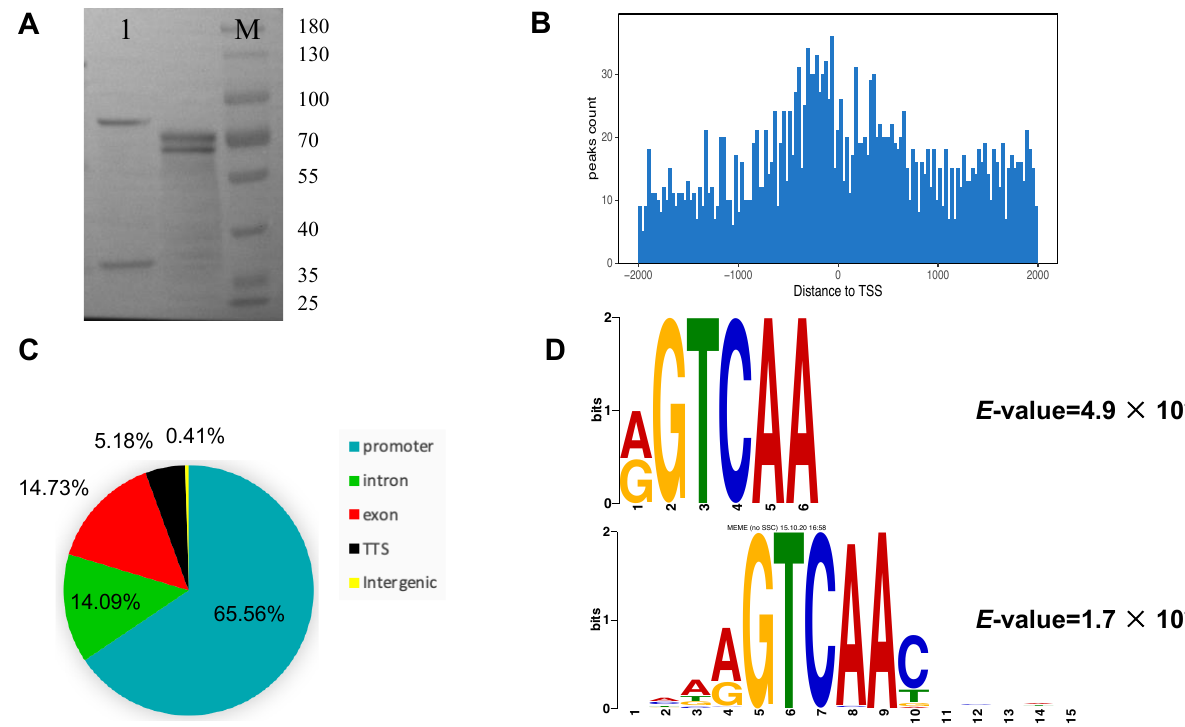
Figure 6. Expression of genome-wide identification of PsnWRKY70 -binding sites. ( A ) Western blot detection of the expression of PsnWRKY70 fusion protein. ( B ) Genomic distribution of PsnWRKY70 - binding peaks. ( C ) Distribution of PsnWRKY70 -binding peaks relative to gene structure. ( D ) Motif analysis of the PsnWRKY70 peak revealed the W-box as the highest enriched